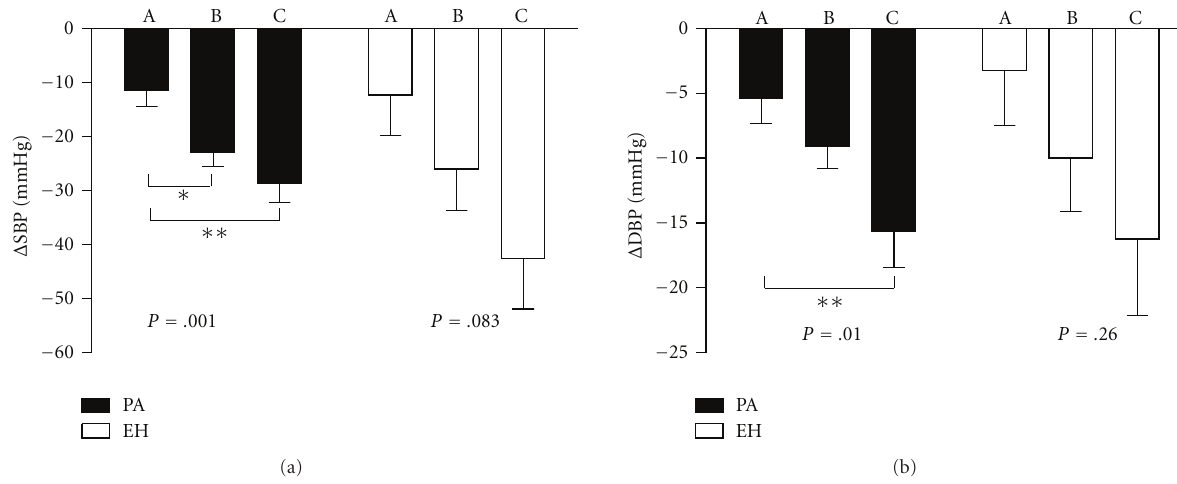
Figure 2: Changes in systolic (SBP) and diastolic (DBP) blood pressure at the end of followup compared to baseline for three categories of followup duration (A < 1 year; B 1–5 years; C > 5 years). P values are for trend tested with one-way ANOVA; indicated significance levels are for di ff erences between groups after adjustment for multiple comparisons. (EH: essential hypertension; PA: primary